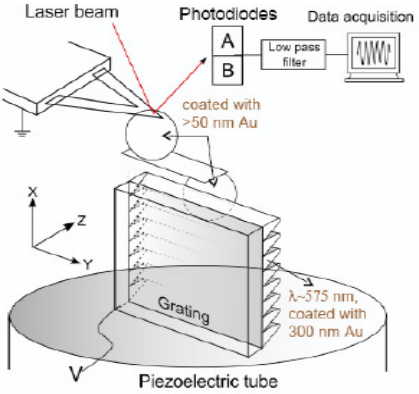
Figure 2. Schematic diagram of the experimental setup using an atomic force microscope for measuring the lateral Casimir force between corrugated surfaces (see the text for further